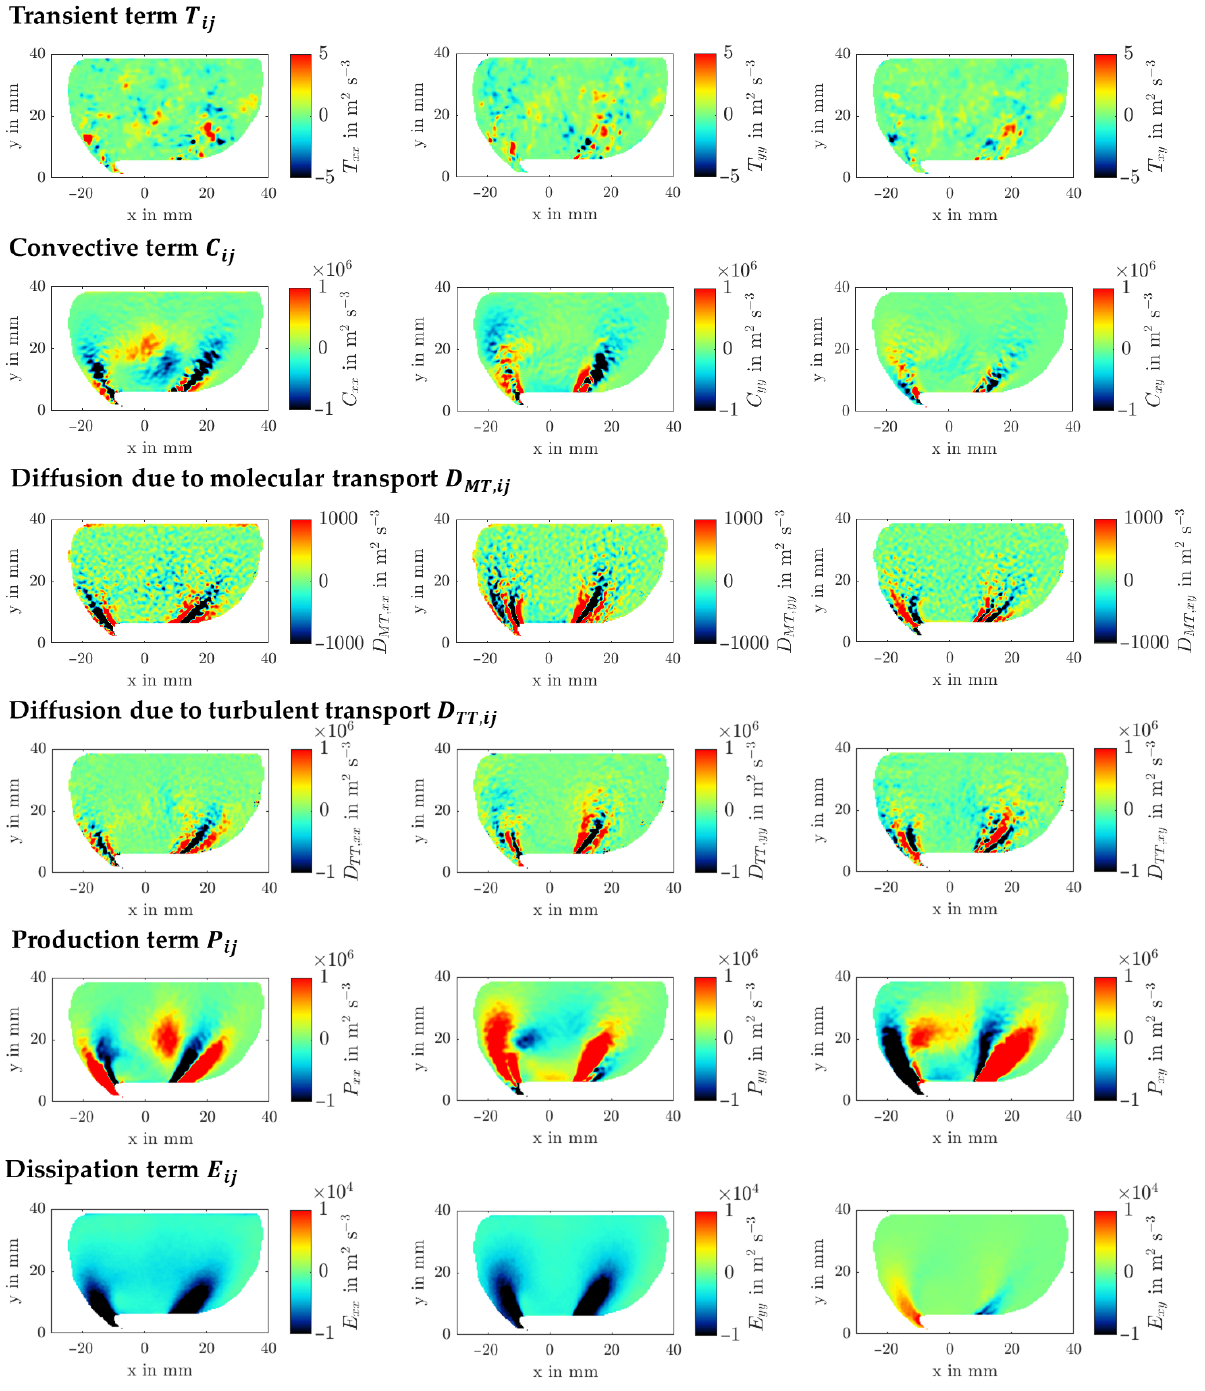
Figure 22. Different components of the specific Reynolds stress transport equations calculated from PIV measurements at 4 mm and 39.6 kg/h, components of xx, yy, and xy from left to right (terms involving third dimension zu z are set to zero).